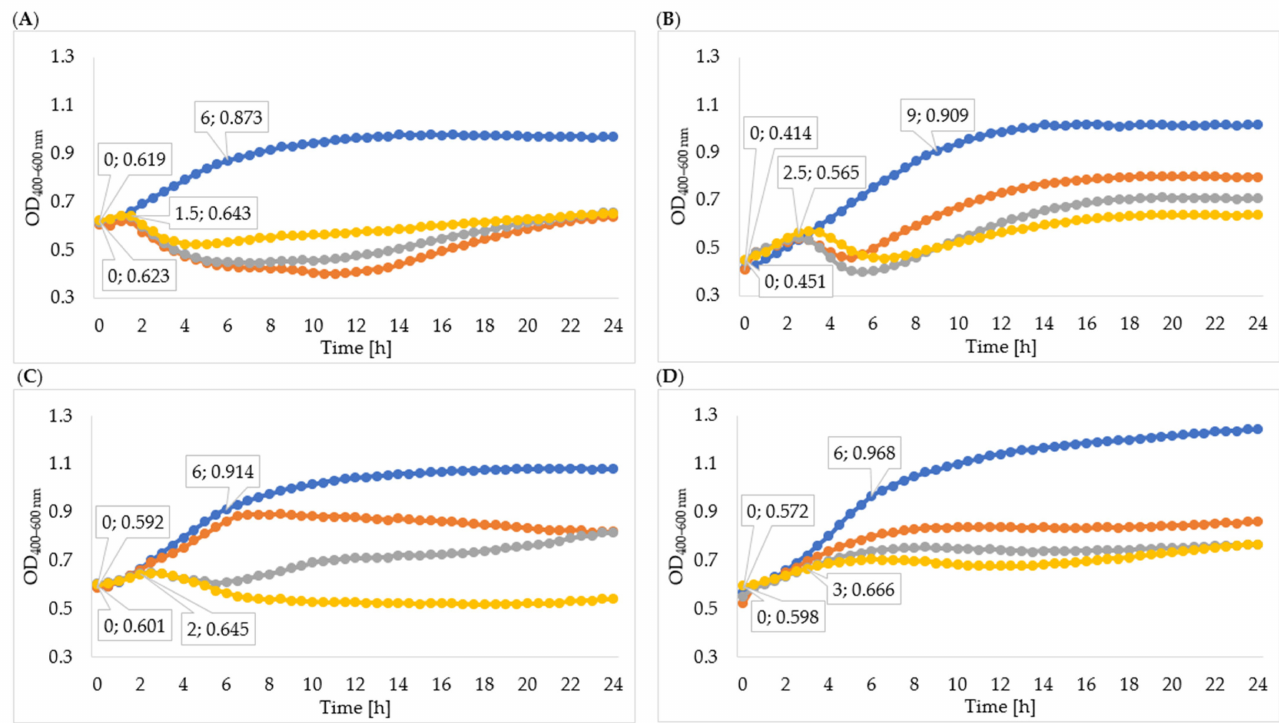
Figure 5. Growth curves of tested bacteria cultured with enzymes isolated through ultracentrifuga- tion: ( A )— Enterobacter cloacae KKP 3082; ( B )— Serratia liquefaciens KKP 3654; ( C )— Enterobacter cloacae KKP 3684; ( D )— Serratia marcescens KKP 3687. The beginning and the end of logarithmic growth phases for control and tested bacteria strains cultured with enzymes isolated after 72-hour propa- gation are marked in the figure ( n = 10). Blue line—control culture, orange line—culture infected with phages propagated for 24 h, grey line—culture infected with phages propagated for 48 h, yellow line—culture infected with phages propagated for 72